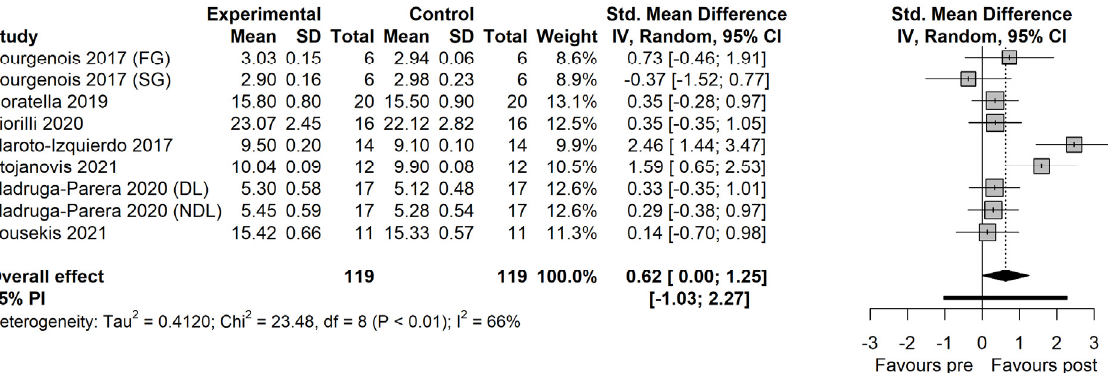
Figure 5. The effects of traditional resistance training on change of direction performance in male athletes [22–28]. FG: fast group; SG: slow group; DL: dominant leg; NDL: non-dominant leg; RL: right